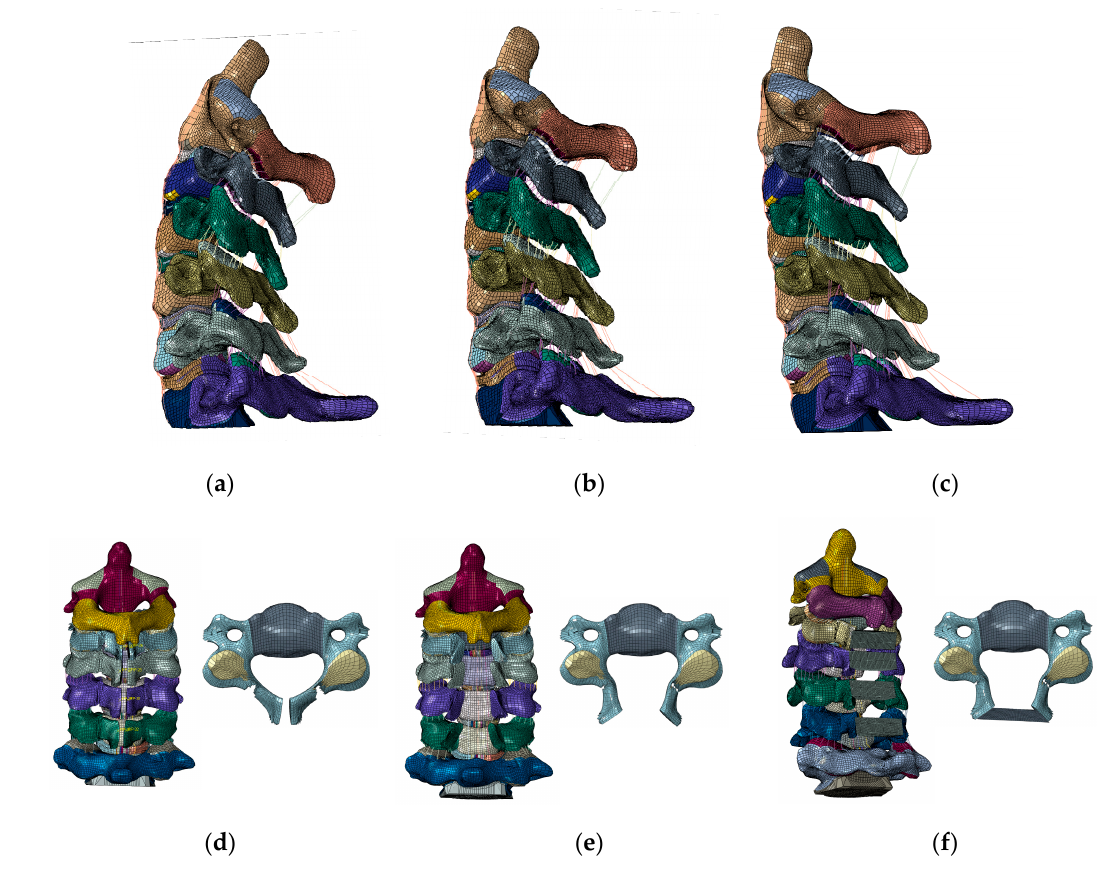
Figure 1. The intact (C2–C7) FE model. ( a ) Lordosis model. ( b ) Straight model. ( c ) Kyphosis model. The laminoplasty model. ( d ) The spinous process was partially resected, about 4 mm of bone from the center of the lamina was cut, and the medial side of both the facet joints was shaved (C3–C6). ( e ) The lamina was opened to the lateral sides. ( f ) The laminoplasty model (C3–C6).